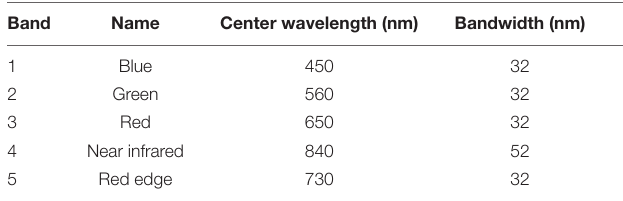
TABLE 1 | Multispectral camera band specifications.